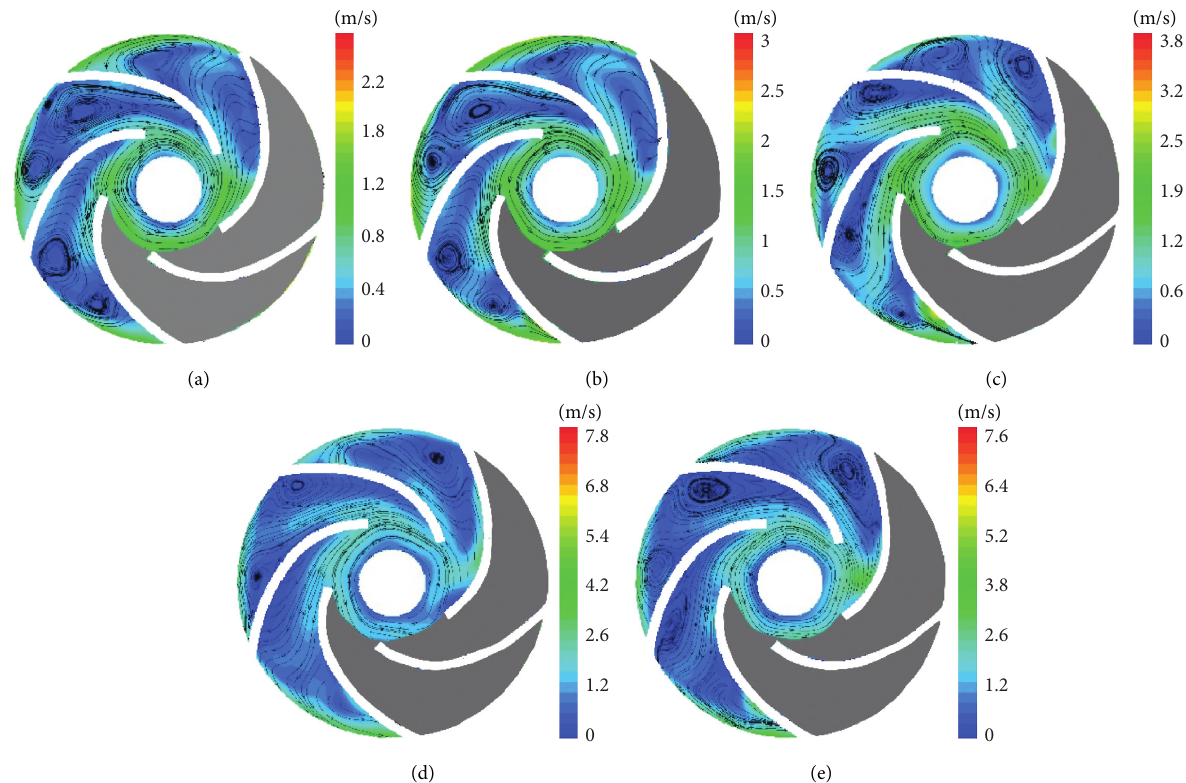
Figure 9: Phase-averaged relative velocity and flow streamlines at the middle span of the impeller, (a) 600r/min 0.2 Q Q BEP , (c) 1000r/min 0.2 Q BEP , (d) 1200r/min 0.2 Q BEP , and (e) 1400r/min 0.2 Q BEP